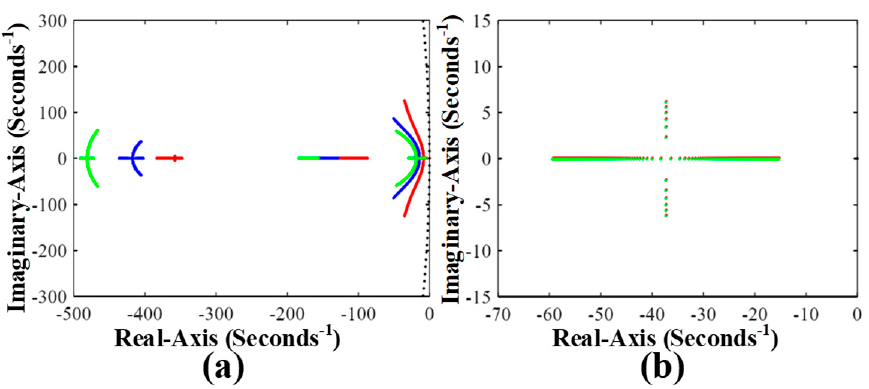
Figure 6. Pole distributions of system between different stator resistance: ( a ) pole distribution diagram of motor before design; ( b ) pole distribution diagram of motor after design.